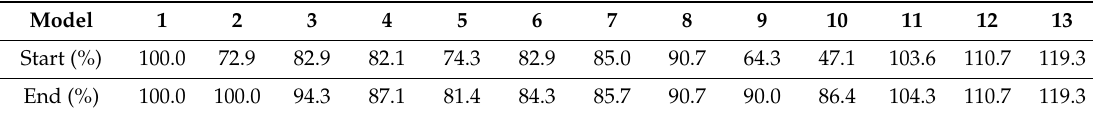
Table 6. Time of damage initiation and final failure, expressed in percentages, in relation to Reference Model 1.